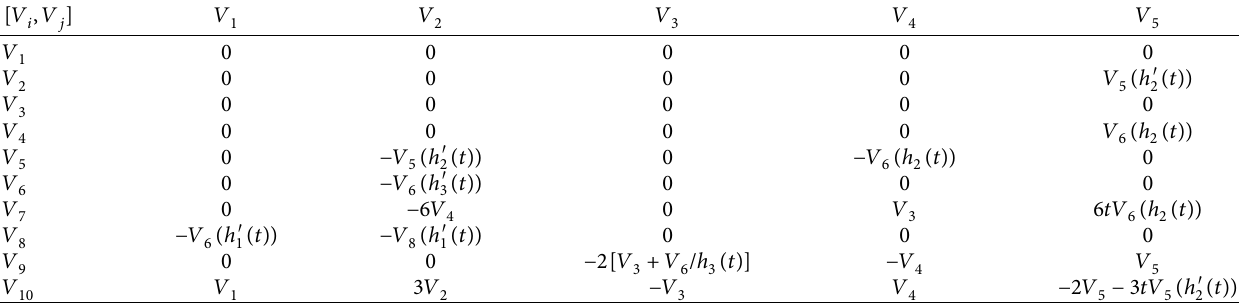
Table 1: Commutator table.